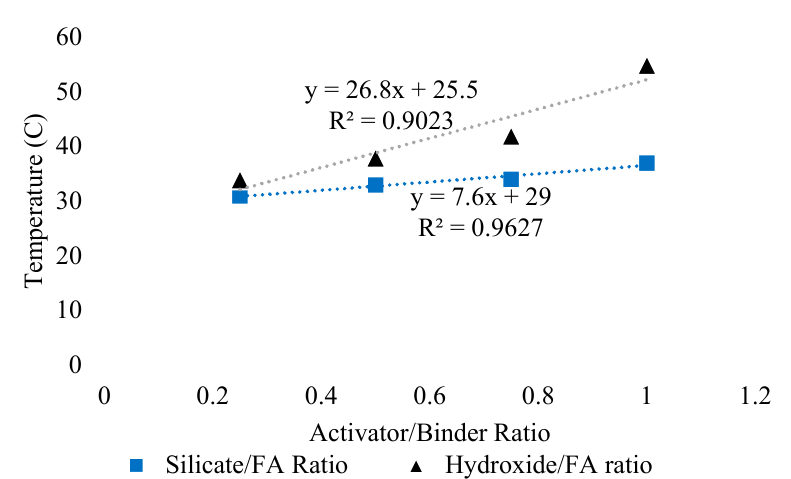
Figure 12. E ff ect of sodium silicate / FA ratio and hydroxide / FA ratio on the temperature, adopted Figure 12. Effect of sodium silicate/FA ratio and hydroxide/FA ratio on the temperature, adopted from [126]; SciELO, from [126]; SciELO, 2014.